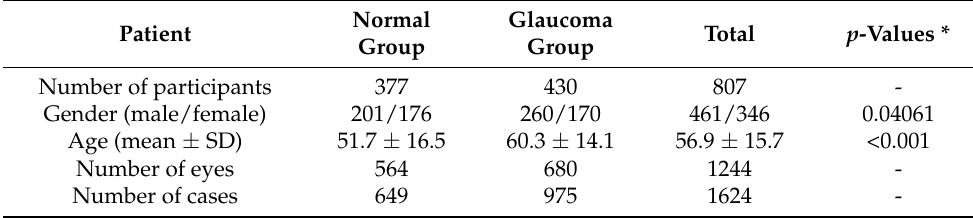
Table 1. Characteristics of the